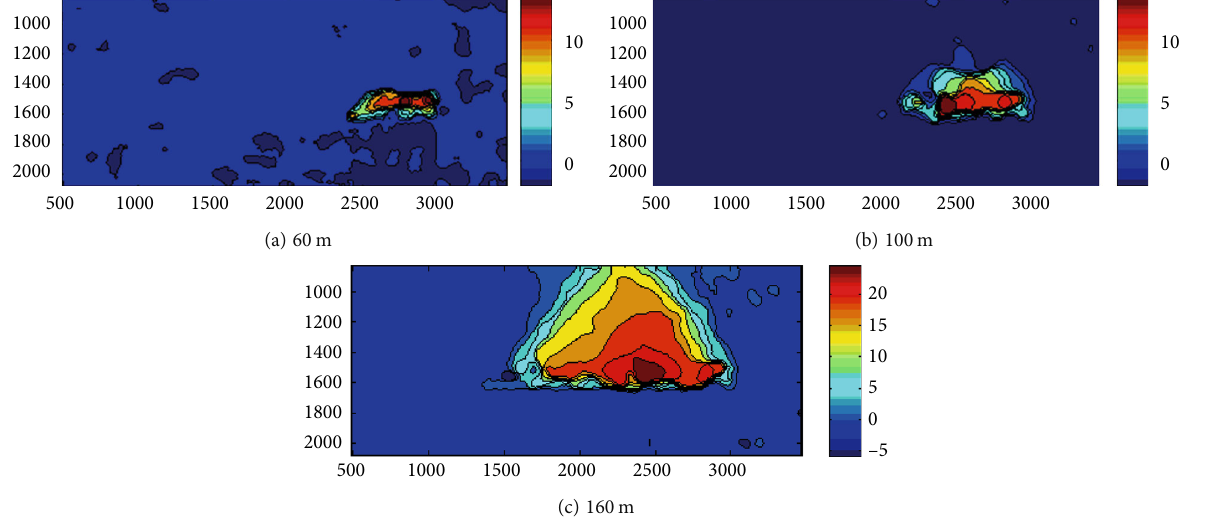
Figure 9: Nephogram of overlying strata displacement with excavation in a 600 m mining depth model.